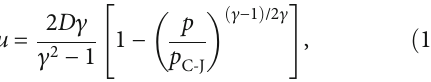
Figure 11, the red and green solid curves represent the shock Hugoniot curve of di ff erent media (copper and water, respec- tively). The value of the slope from the original point to any